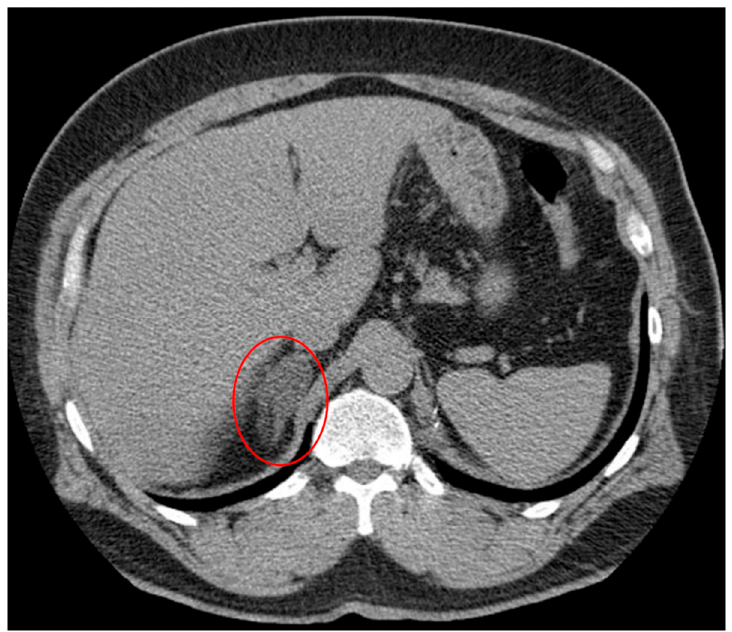
Figure 1. Incidental right adrenal nodule discovered on non-contrast CT. Case courtesy of Dr. Hani Makky Al Salam, Radiopaedia.org. rID:10109 [9].